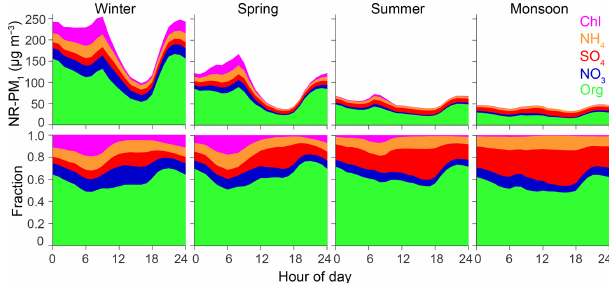
Figure 5. Stacked average absolute and fractional diurnal profiles of NR-PM 1 species by